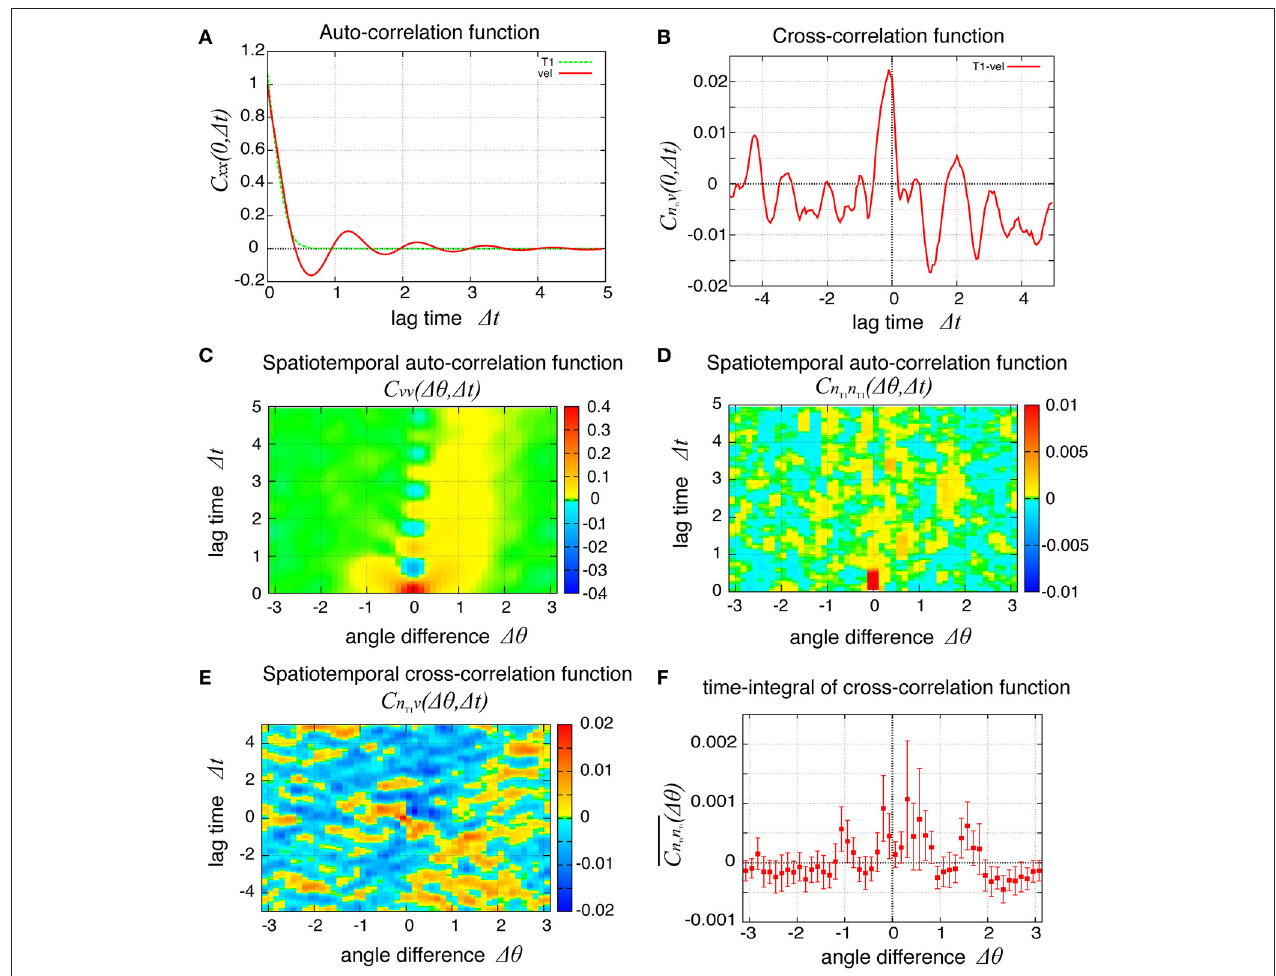
FIGURE 9 | Spatiotemporal correlation functions for K p 7.5 in the presence of chiral line tension fluctuation, showing the spatial propagation of cell rearrangements. = (A) Temporal auto-correlation function of the local angular velocity and the local frequency of T1 transitions (red and green lines, respectively). (B) Temporal cross-correlation function between the two quantities. (C,D) Spatiotemporal correlation function of the local angular velocity (C) and the local frequency of T1 transition (D) . (E) Spatiotemporal correlation function between the two quantities. (F) Integrated spatiotemporal correlation C n T1 n T1 ( ∆θ ) of (D) along the time 5 C n T1 n T1 (∆θ , ∆ t ) d ( ∆ t ), where C is the spatiotemporal correlation function. To obtained the plot, difference between ∆ t 1 and ∆ t 5, given by C n T1 n T1 ( ∆θ ) = = = R 1 132 simulations were carried out with different values of the random parameters, the frequency f kl and the initial phase δ kl of tension fluctuation. The integration C n T1 n T1 (∆θ) was first performed for each simulation. Then, the means over the 132 simulations were plotted (marks) against the angle difference ∆θ . Vertical bars indicate 95 percent confidence intervals of the means among the 132